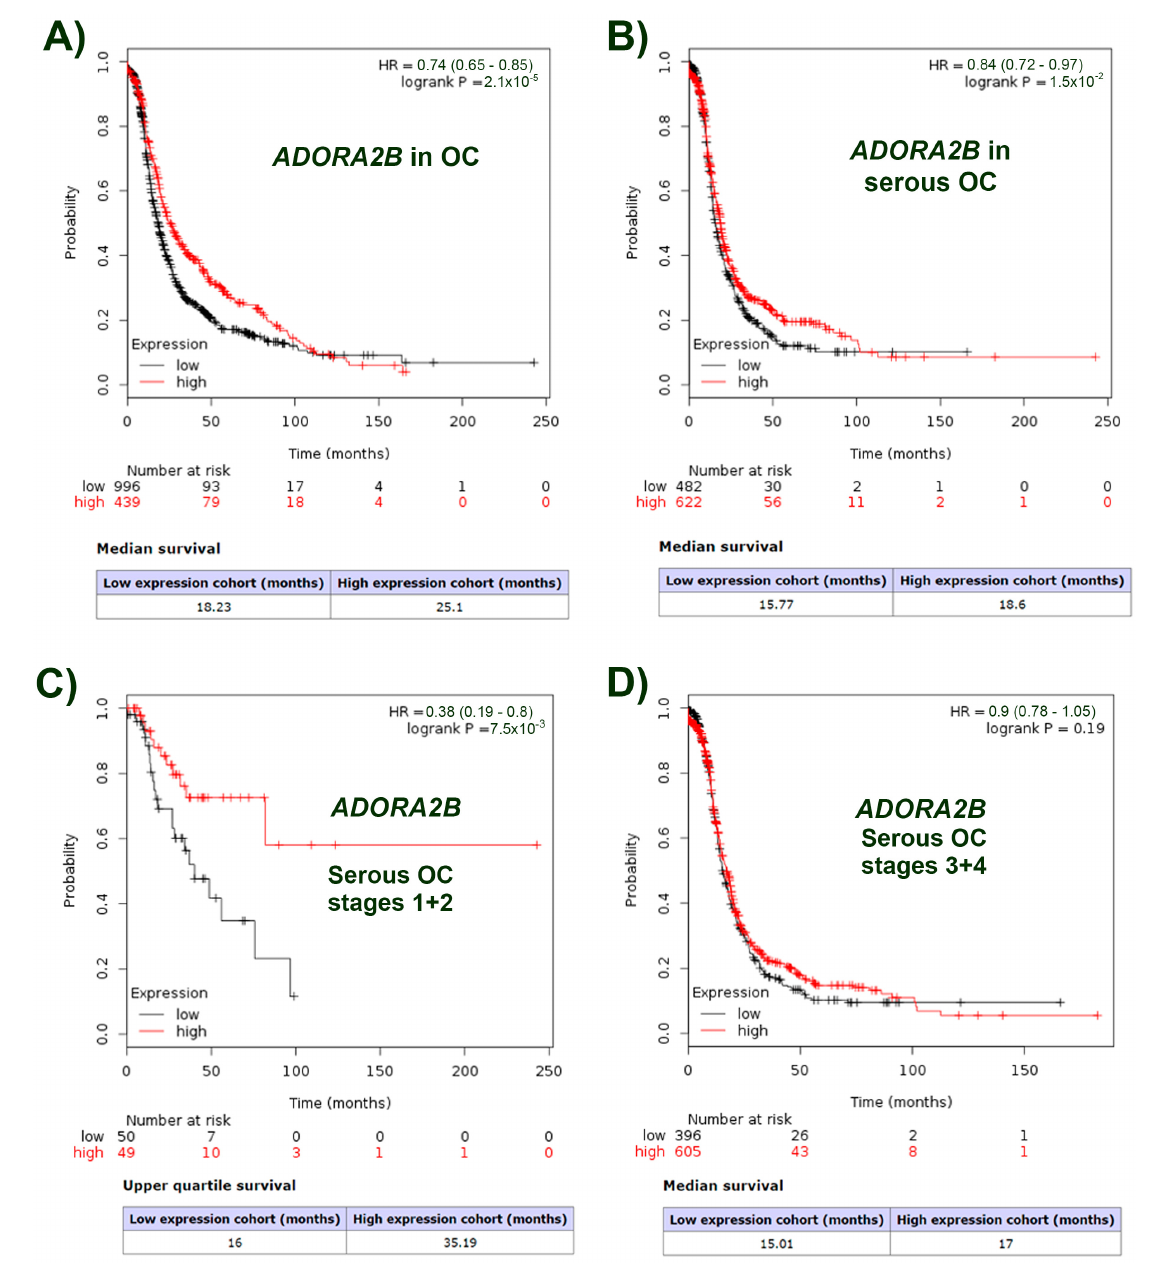
Figure 1. Relation between ADORA2B transcript (coding for A2BR) and survival time for patients with OC. Kaplan–Meier plots were constructed for the ADORA2B transcript using the Kaplan– Meier plotter database (KMPdb) for ( A ) Ovarian carcinoma in general carcinoma patients (996 low expression and 439 high expression); ( B ) Serous ovarian carcinoma patients (482 low expression and 622 high expression); ( C ) Serous ovarian carcinoma patients in stages 1 + 2 (50 low expression and 49 high expression) and ( D ) Serous ovarian carcinoma patients in stages 3 + 4 (396 low expression and 605 high